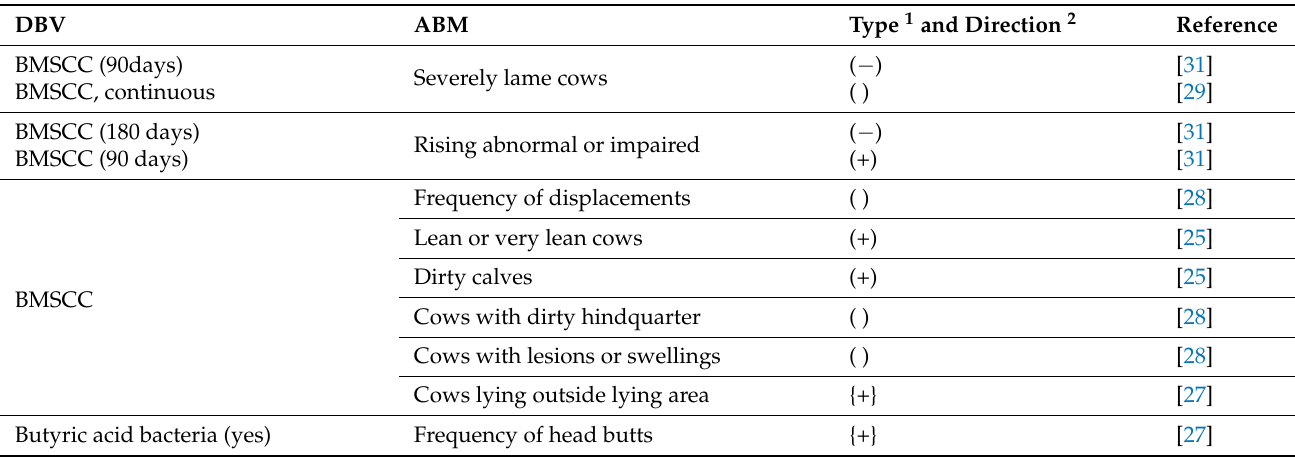
Abbreviations: BMSCC = bulk milk somatic cell count. 1 Type of associations indicated by ( ) for univariable associations and { } for multivariable associations. 2 Direction of associations indicated by + for positive associations, − for negative associations, empty brackets indicate that no direction was